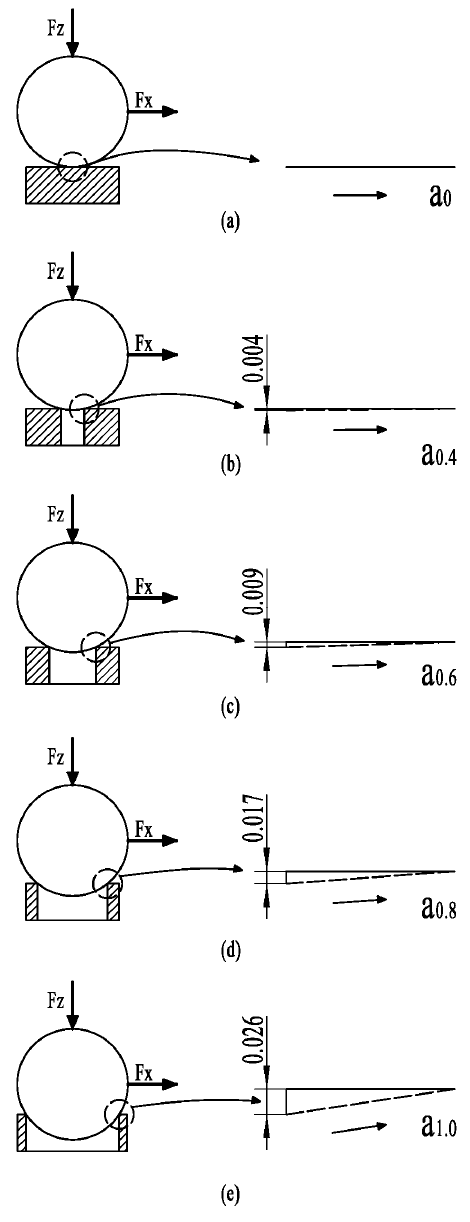
Figure 7. Schematic diagram of collision climbing: ( a ) untexture; ( b ) 0.4 mm groove width mechan ‐ ical texture; ( c ) 0.6 mm groove width mechanical texture; ( d ) 0.8 mm groove width mechanical texture; ( e ) 1.0 mm groove width mechanical texture.